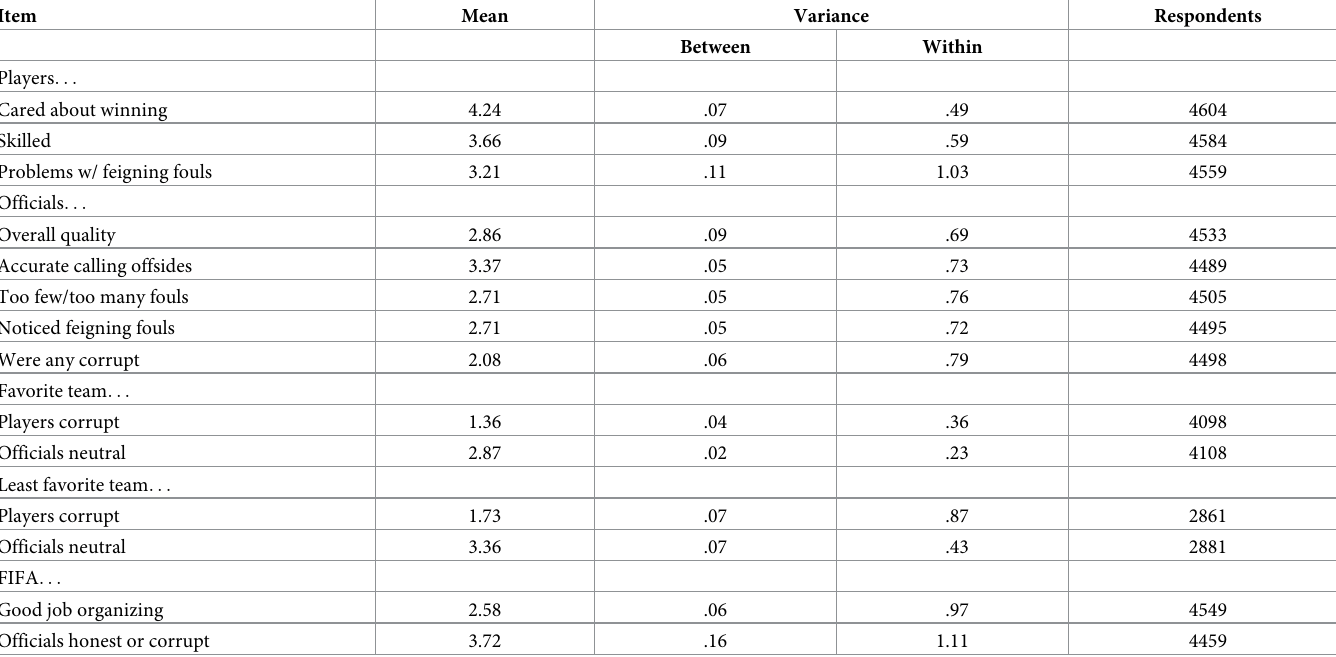
Table 2. Descriptive statistics for survey responses concerning players, officials, and